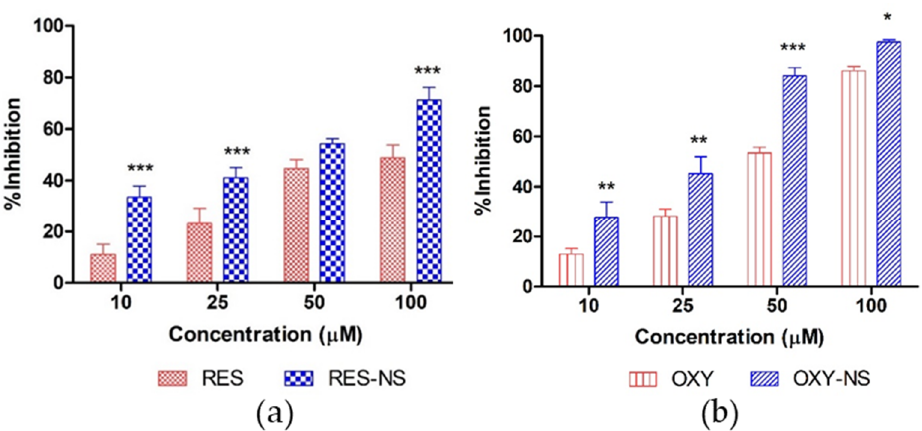
Figure 10. DPPH inhibition activity of ( a ) RES vs. RES-NS and ( b ) OXY vs. OXY-NS. * p < 0.05, ** p < 0.01, and *** p < 0.001 indicates a significant di ff erence between RES vs. RES-NS or OXY vs. OXY-NS at the same concentrations, two-way ANOVA, followed Bonferroni correction.